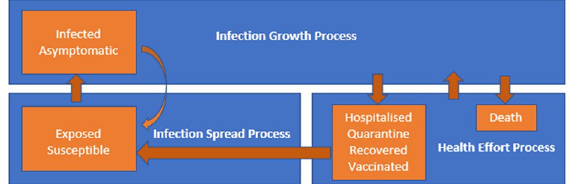
Figure 6. Epidemic Process Framework shows the topology and dependencies of the three main processes: Infection Spread Process (ISP), Infection Growth Process (IGP), and Health Efforts Process (HEP), which also includes process interaction channels.